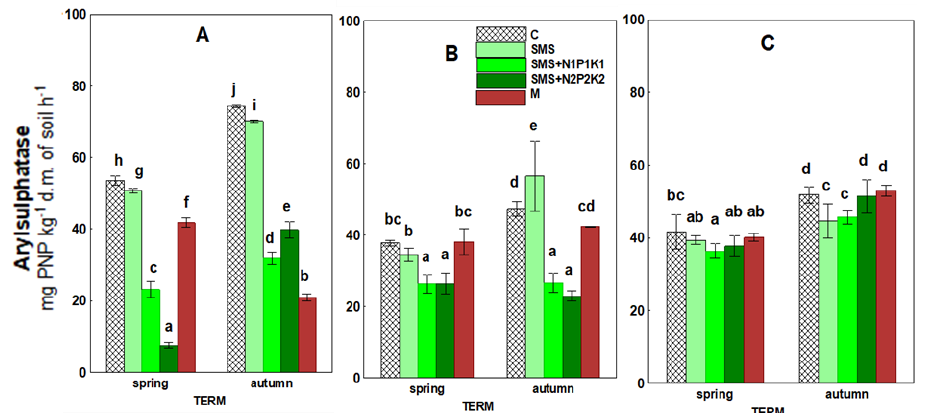
Figure 6. Arylsulfatase activity in control soil and soil under different treatment strategies. ( A )—1st year; ( B )—2nd year; ( C )—3rd year. C—control soil; SMS—soil + spent mushroom substrate; SMS + N1P1K1—soil + spent mushroom substrate + mineral fertilization N1P1K1; SMS + N2P2K2—soil + spent mushroom substrate + mineral fertilization N2P2K2; M—soil + manure. The vertical lines indicate the standard deviation. Different letters above the columns indicate significant differences at p < 0.05, and each year was analyzed independent of each